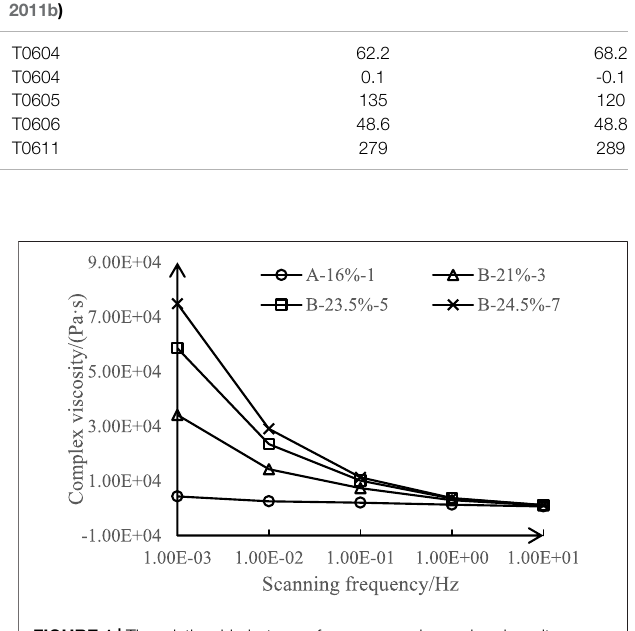
FIGURE 1 | The relationship between frequency and complex viscosity obtained by frequency scanning of different rubber modi fi ed asphalt